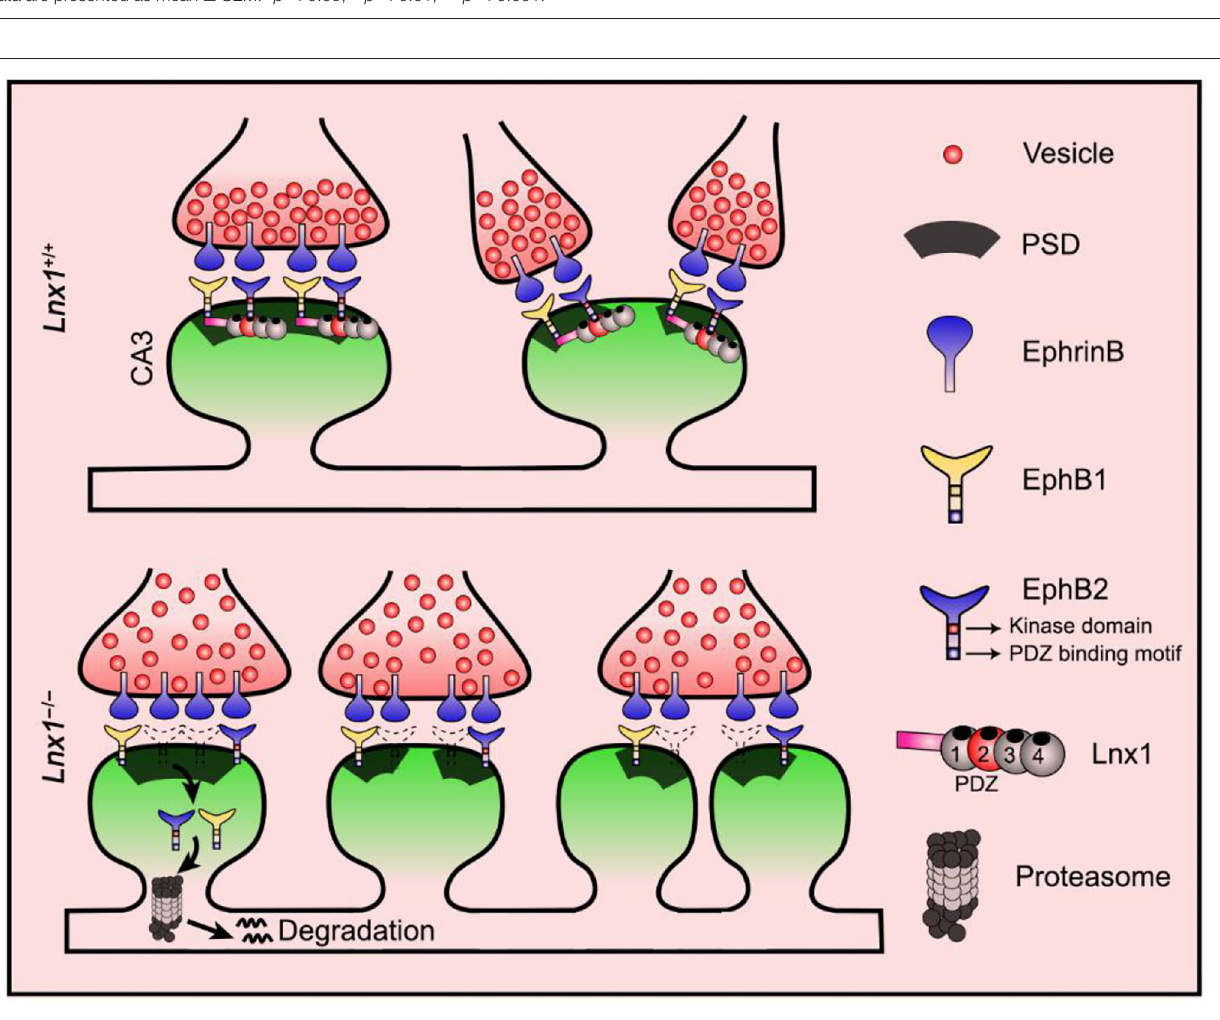
FIGURE 5 | Proposed model for diversiform synaptogenesis through Lnx1-EphB signaling. Ligand of Numb protein X 1 (Lnx1) serves as a specific protein stabilizer for postsynaptic EphB receptors in hippocampal CA3 pyramidal neurons to sculpt postsynaptic structure and promote diversiform synaptogenesis during the developing hippocampus. PSD, postsynaptic